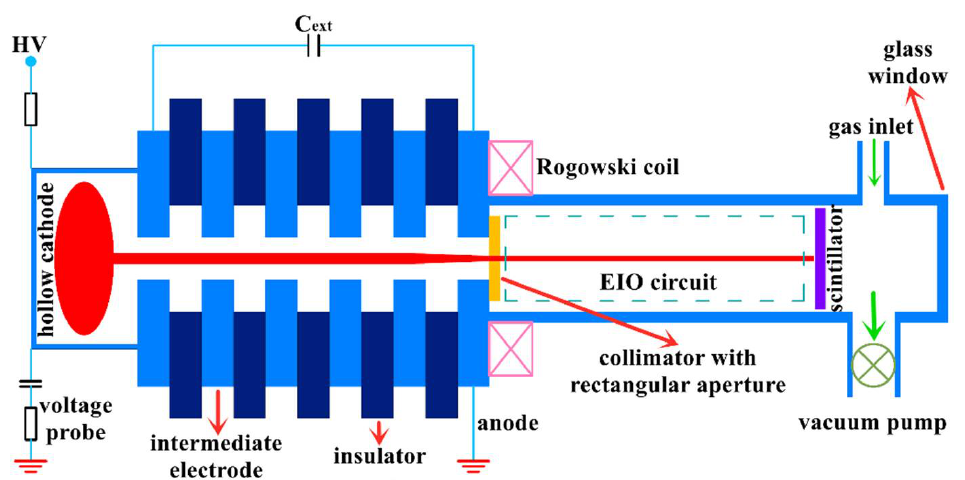
Figure 1. A PS electron source experimental device.